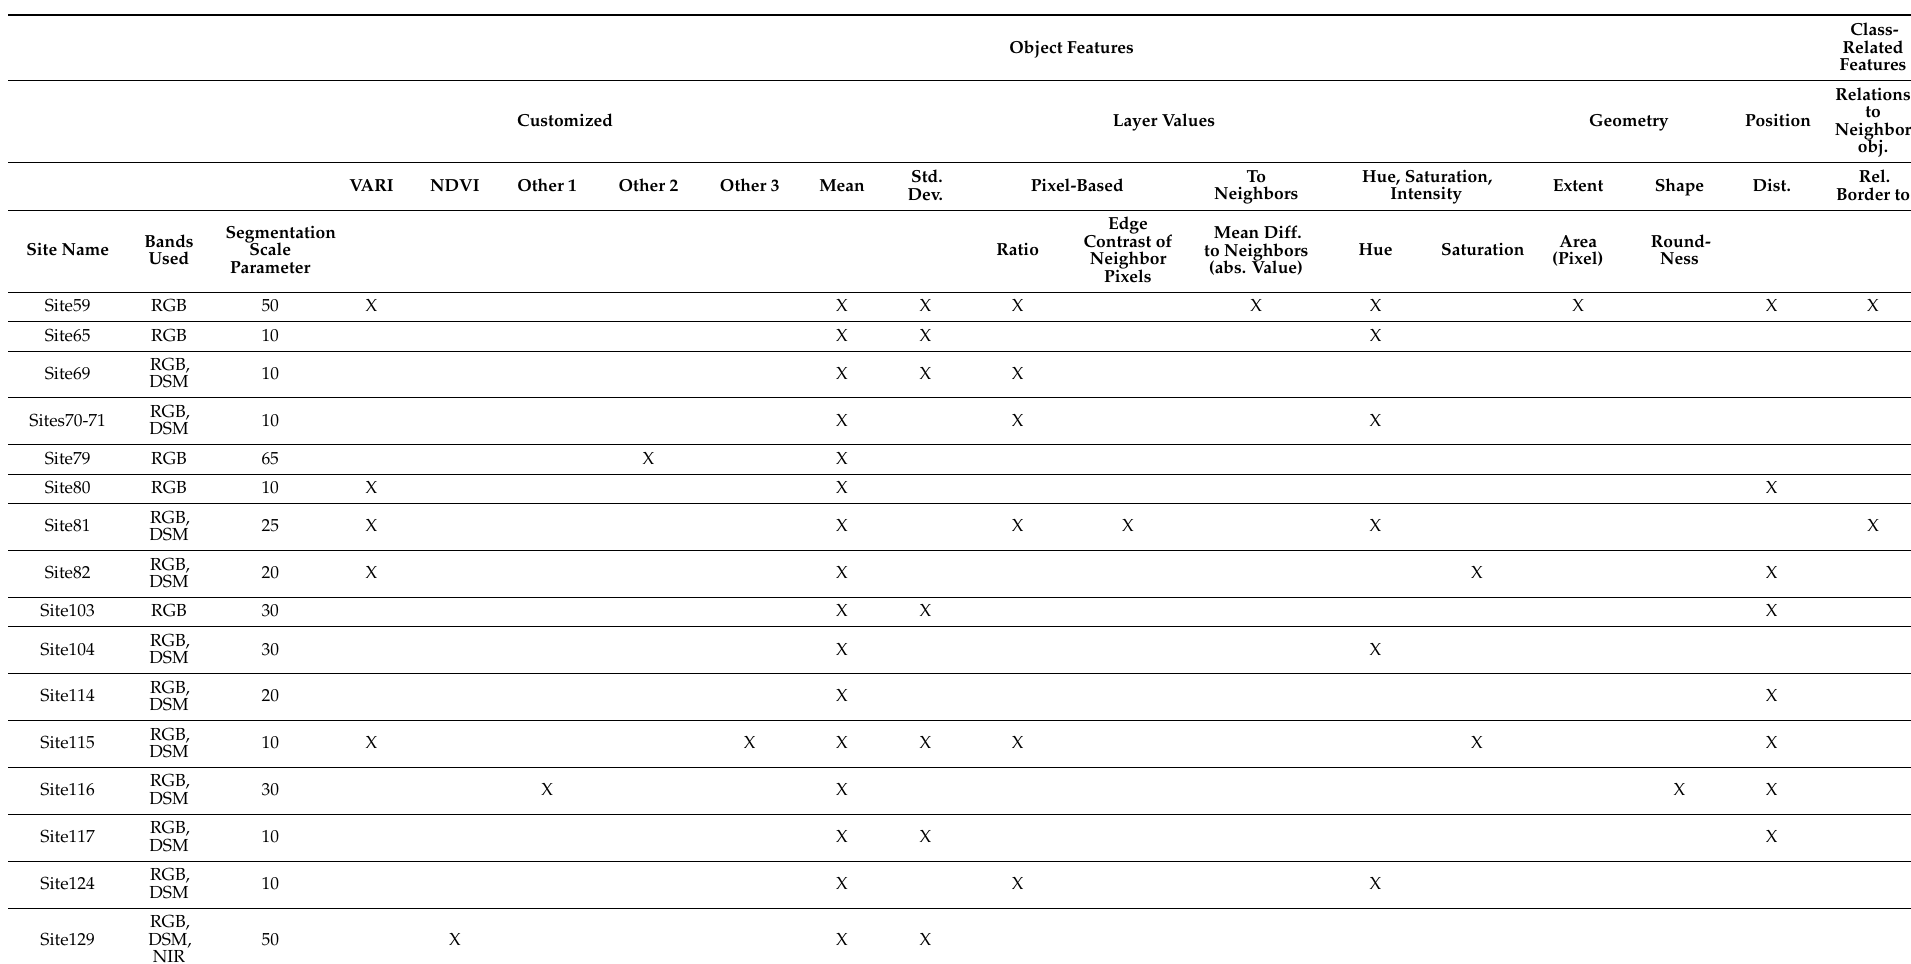
Table 4. Layers and classification parameters used for each site. The first column lists the site name. The second column identifies the imagery bands used to generate the image classification in eCognition, including red green blue (RGB) and/or the digital surface model (DSM). The third column identifies the scale parameter used in the initial image segmentation. The remaining columns identify the specific parameters used in the image classifier, organized based upon the same categorical hierarchies as they appear in